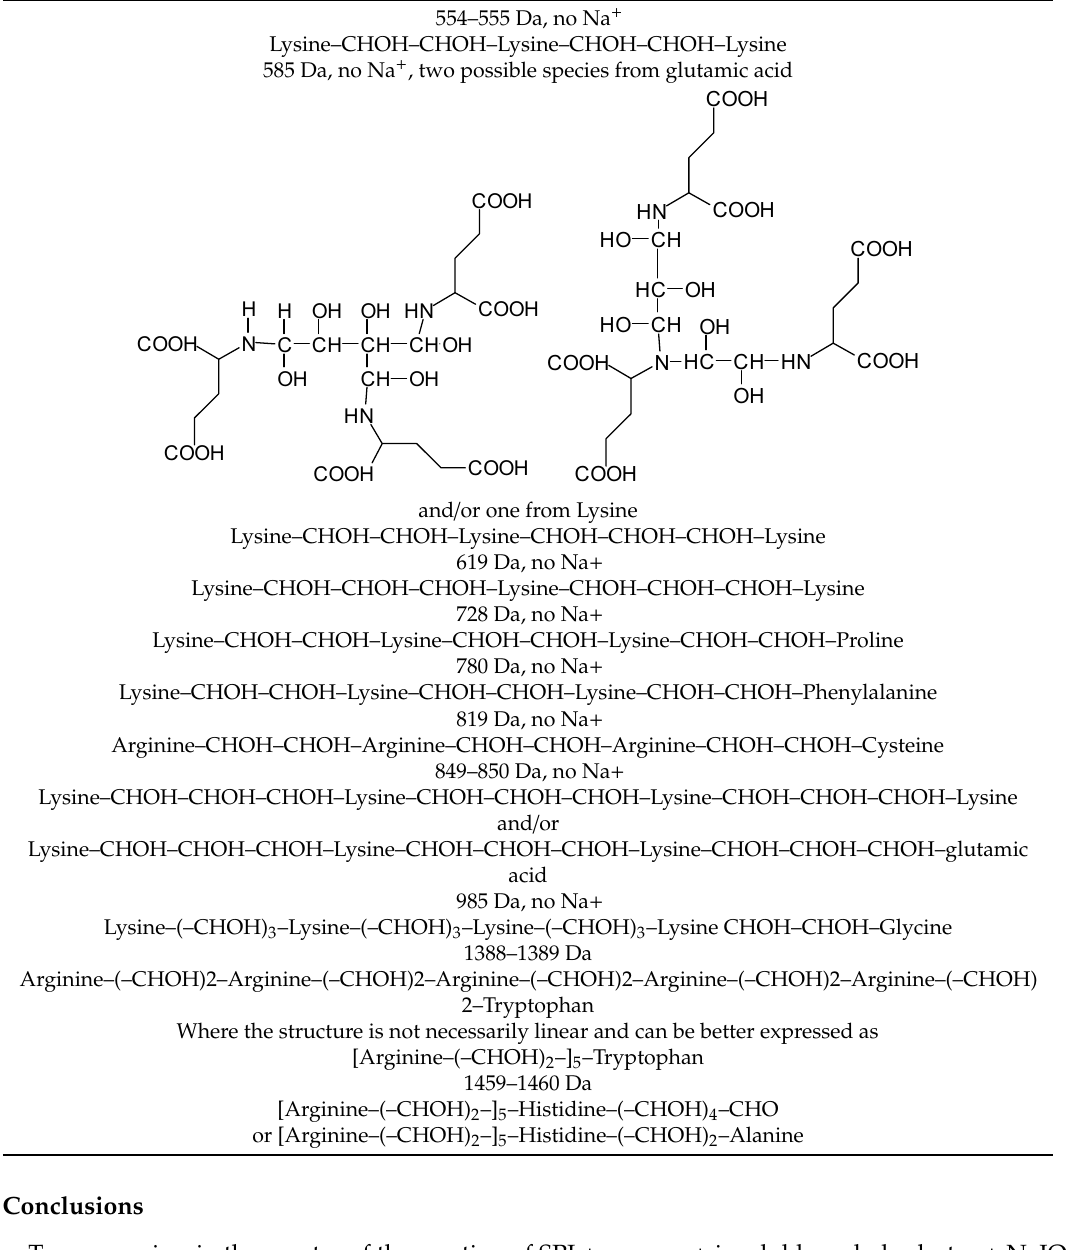
Table 3. Some possible assignments from the MALDI ToF spectra in Figure 3a,b,c of the reaction of SPI + sucrose + insoluble soy carbohydrates + NaIO4 for peaks not belonging to any of the single periodate-treated constituent components.